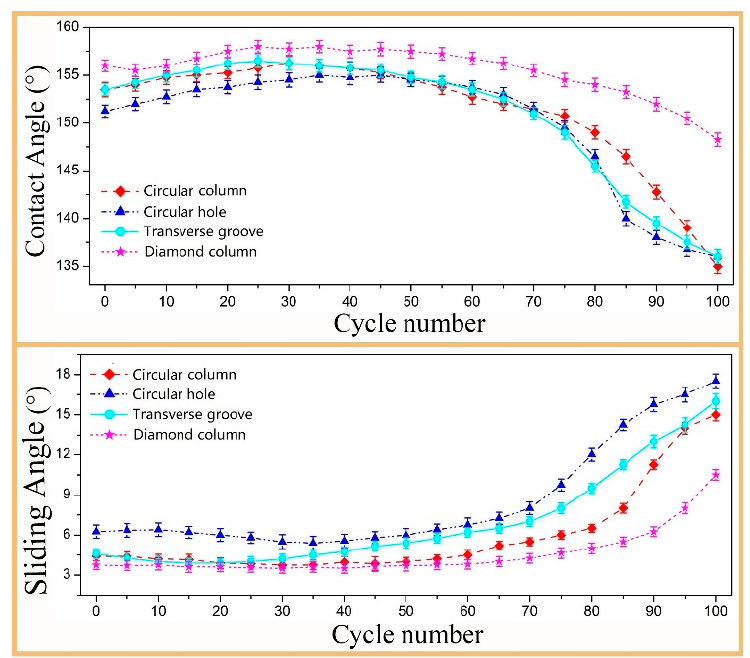
Figure 8. Curves of the CA values and SA values against the abrasion cycles.